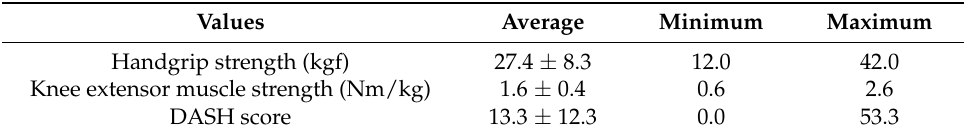
Table 2. Handgrip strength, knee extensor muscle strength, and Disabilities of the Arm, Shoulder, and Hand (DASH) scores of the patients.